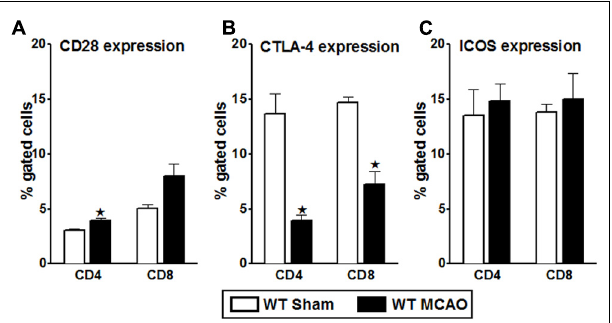
FIGURE 1 | Characterization of co-stimulatory molecules onT-cells of WT splenocytes, post-MCAO. Splenocytes from sham- and MCAO-subjectedWT mice were harvested 96 h after MCAO (60 min) and assessed for expression of: (A) CD28; (B) CTLA-4; and (C) ICOS on gated CD4 + and CD8 + T-cells.Values represent mean numbers ( ± SEM) of indicated cell subsets, gated on live leukocytes (by PI exclusion), from 4–5 mice of each group, from two separate experiments. Statistical analysis was performed using Student’s t- test. Significant differences between sample means are indicated as * p ≤ 0.05 as compared to the sham-treated WT mice. compared to the baseline